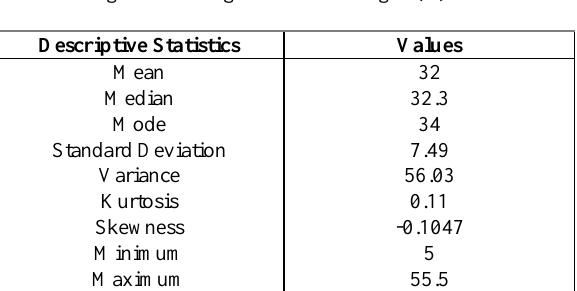
Figure 5. Histogram of Tree Height (m) values